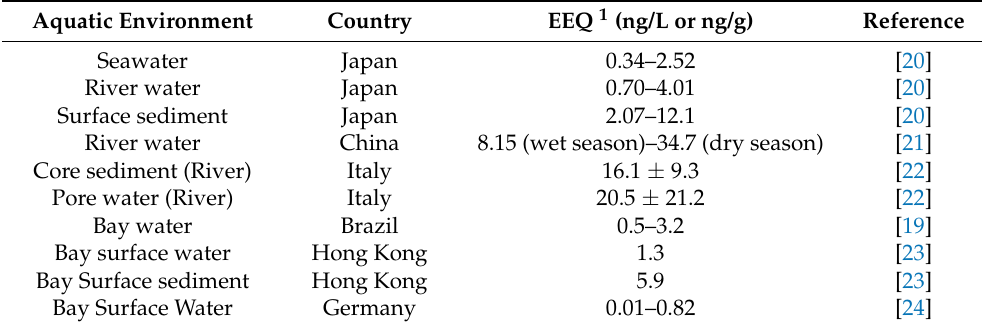
Table 1. Examples of studies that documented the range of estrogenic activities in the aquatic